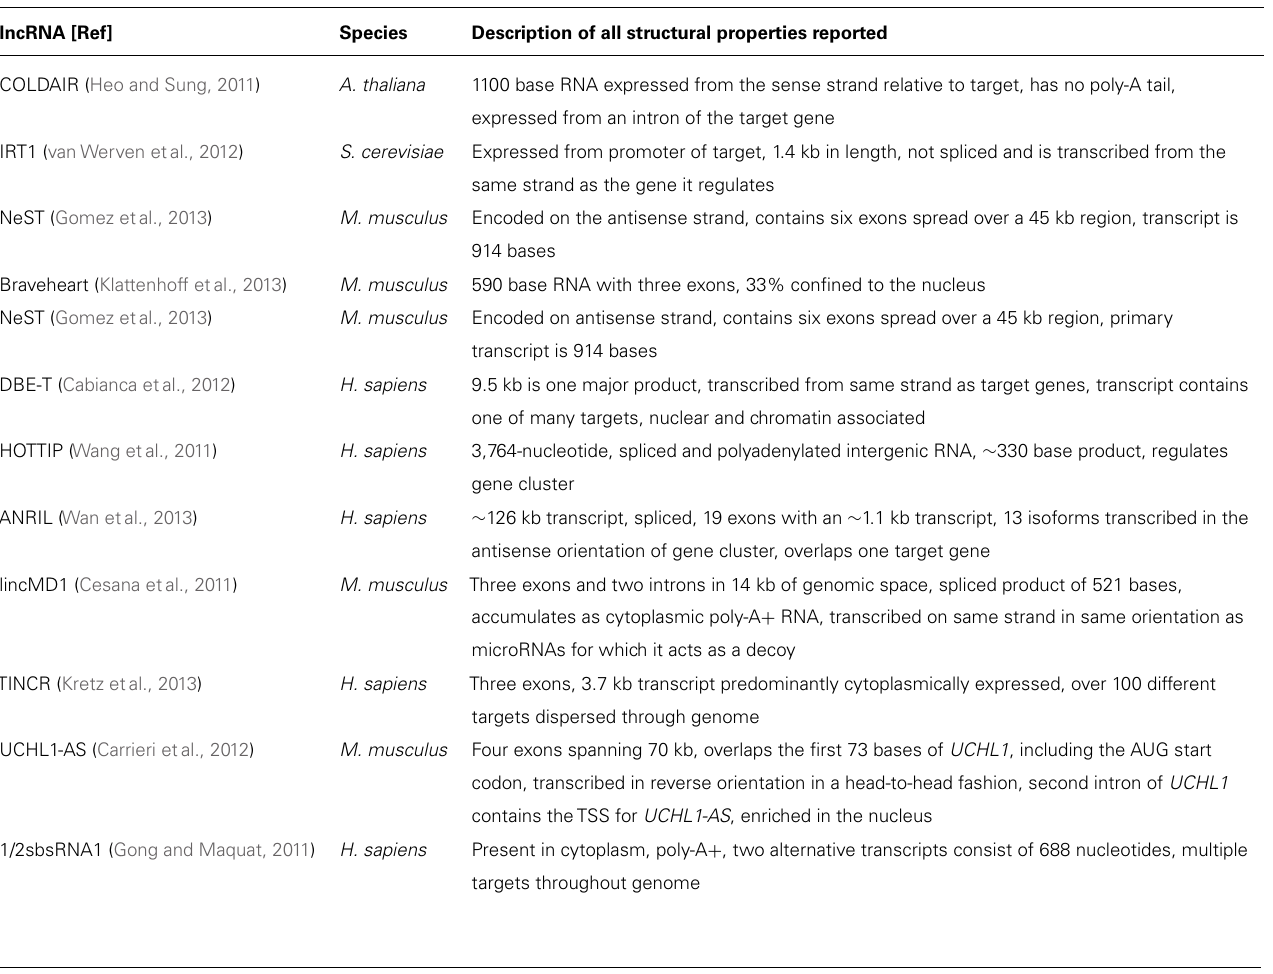
Table 2 | Processing and positional diversity of lncRNA (in order described in